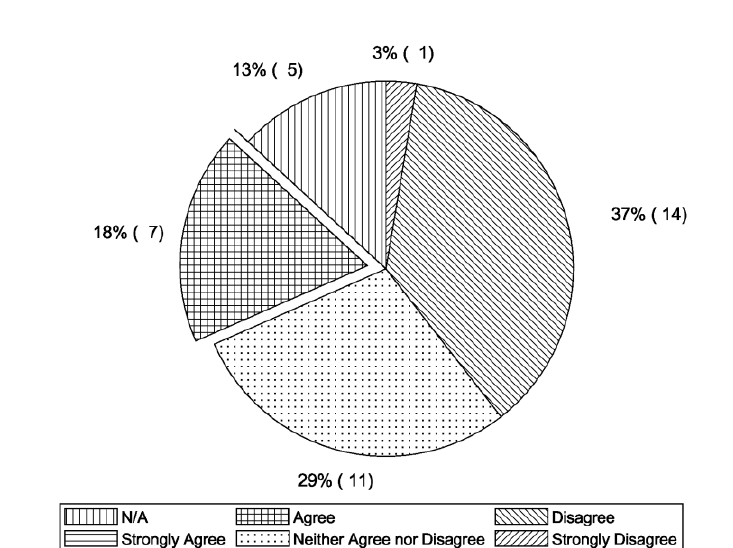
Fig. 15. Presentations affect students to change the engineering major that they chose before taking this